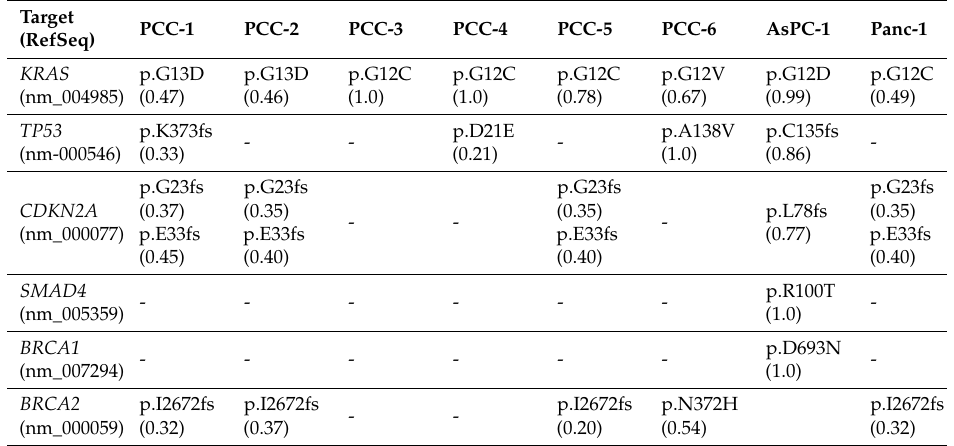
Table 3. Mutation profiles of PDAC-derived primary PCC cultures with allele fraction (AF) values.